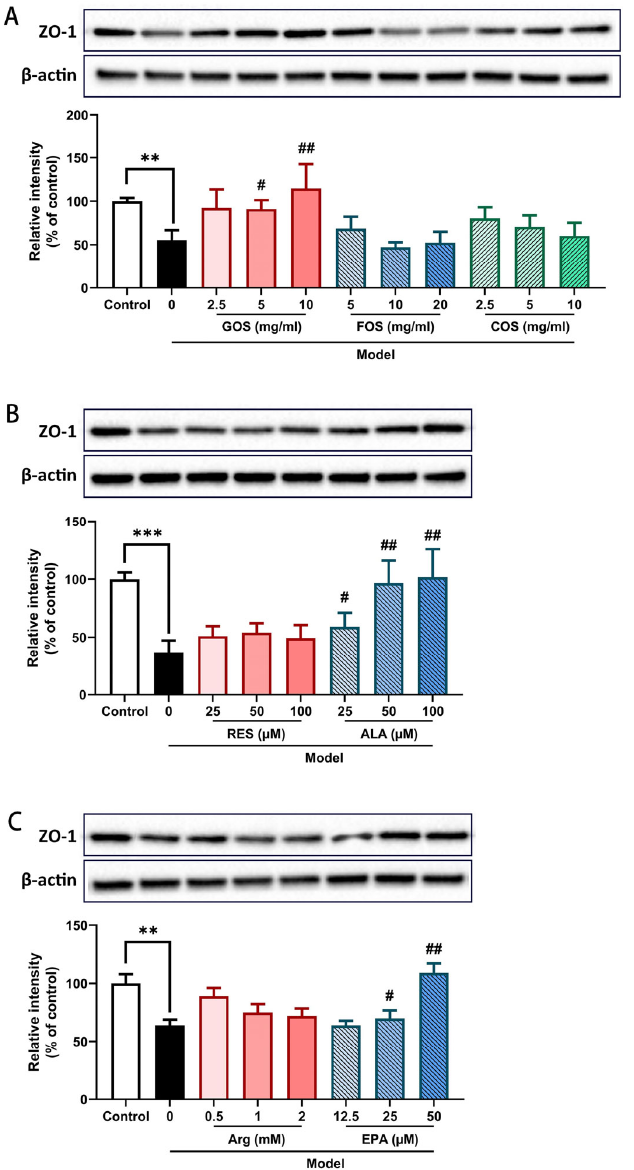
Figure 4. Relative ZO-1 protein expression level in Caco-2/HT-29 cell monolayers pre-incubated with GOS, FOS, COS ( A ), RES, ALA ( B ), Arg, and EPA ( C ) for 48 h then exposed to hypoxia and heat treatment (2 h). ZO-1 protein expression was determined by WB and normalized to β -actin. All values were presented as means ± SEM (N = 3, n = 2 (GOS, FOS, COS group), and n = 3 (all other groups)). Statistical differences were analyzed by two-way ANOVA followed by the Bonferroni’s multiple comparison test. ** p < 0.01 and *** p < 0.001 versus control; # p < 0.05 and ## p < 0.01 versus model. GOS, galacto-oligosaccharides; FOS, fructo-oligosaccharides; COS, chitosan oligosaccharides; ALA, α -lipoic acid; RES, resveratrol; Arg, l-arginine; EPA, eicosapentaenoic acid. The original uncropped bands are included in the Supplementary